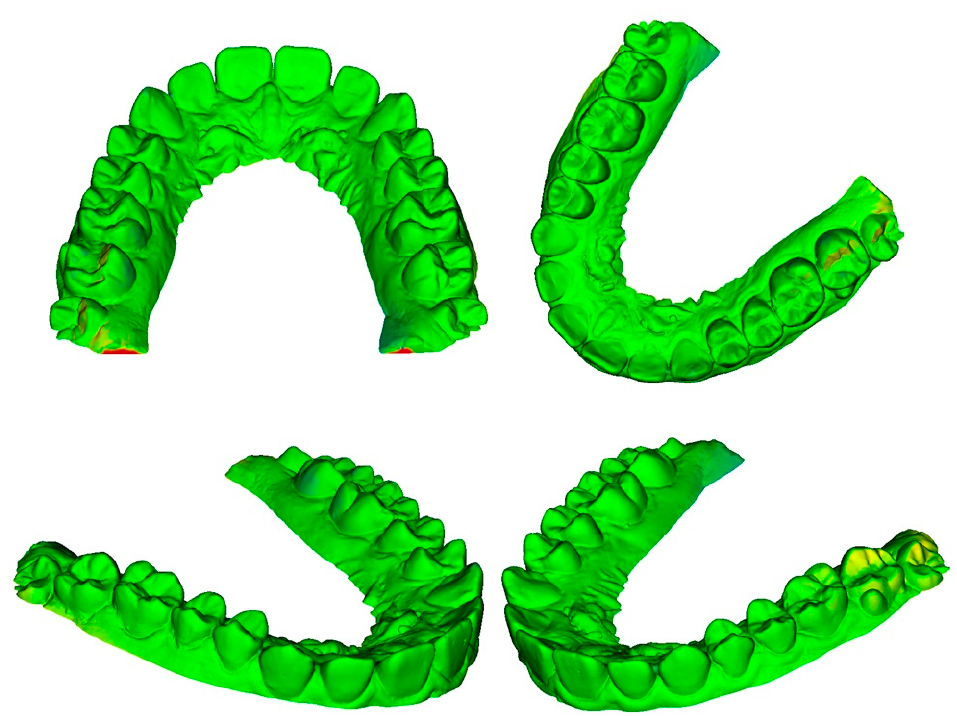
Figure 10. Superimposition between dental extraoral laboratory scanner and intraoral scanner.